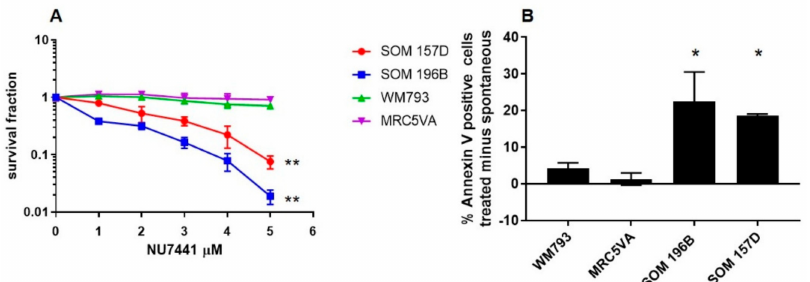
Figure 4. The sensitivity of the UM cell lines to DNA-PK inhibitor NU7441. ( A ) The UM cell lines SOM 157D and SOM 196B were sensitive to treatment with NU7441 DNA-PK inhibitor compared to the control cell lines (** P = 0.0088 and ** P = 0.0043 respectively by a Student’s T test). ( B ) The percentage of apoptotic cells as suggested by Annexin V positivity was significantly increased in the UM cell lines SOM 157D and 196B in response to treatment with 2.5 µ M NU7441 for 48 h compared to controls (* P = < 0.05). The error bars indicate the standard deviation in three independent